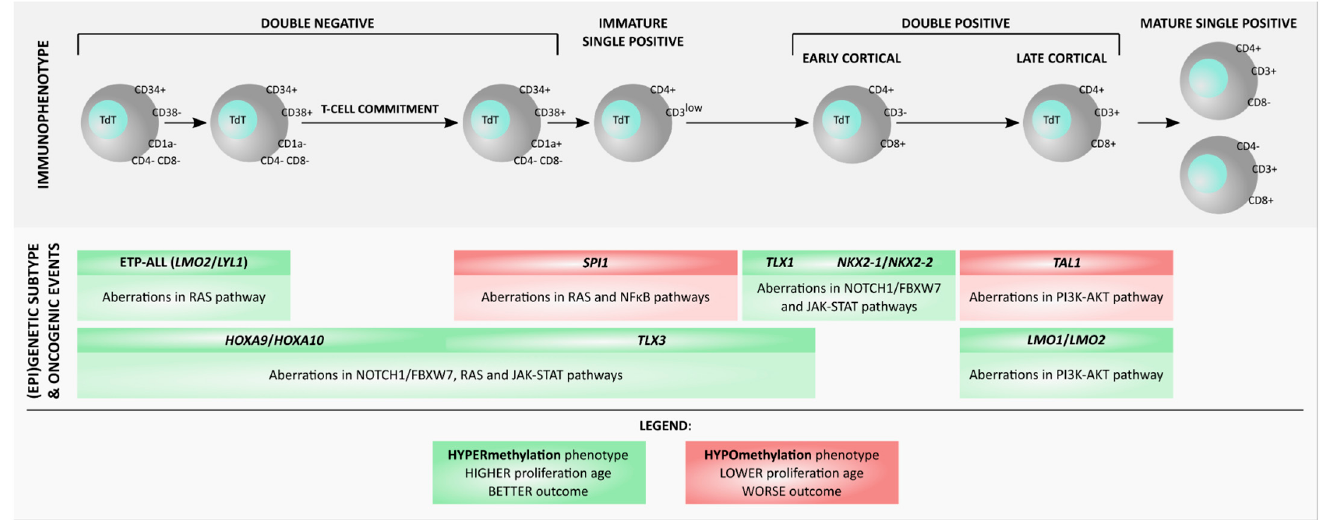
Figure 1. (Epi-)genetic subtypes of T-ALL, based on the findings from reviewed research [75–78,81–83] .